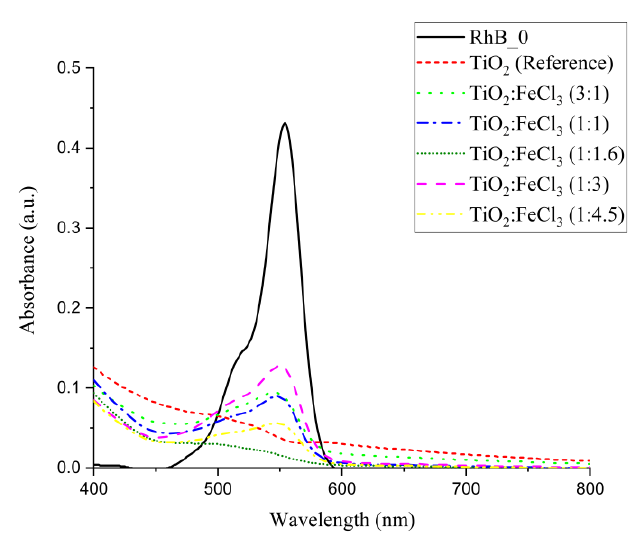
Figure 8. Absorbance degradation curves of RhB solution after 3 h of exposure to solar irradiation for the different ratios of doped TiO 2 :FeCl 3 and TiO 2 (reference). Where RhB_0 is the RhB solution (2 ppm) at time 0 not irradiated.